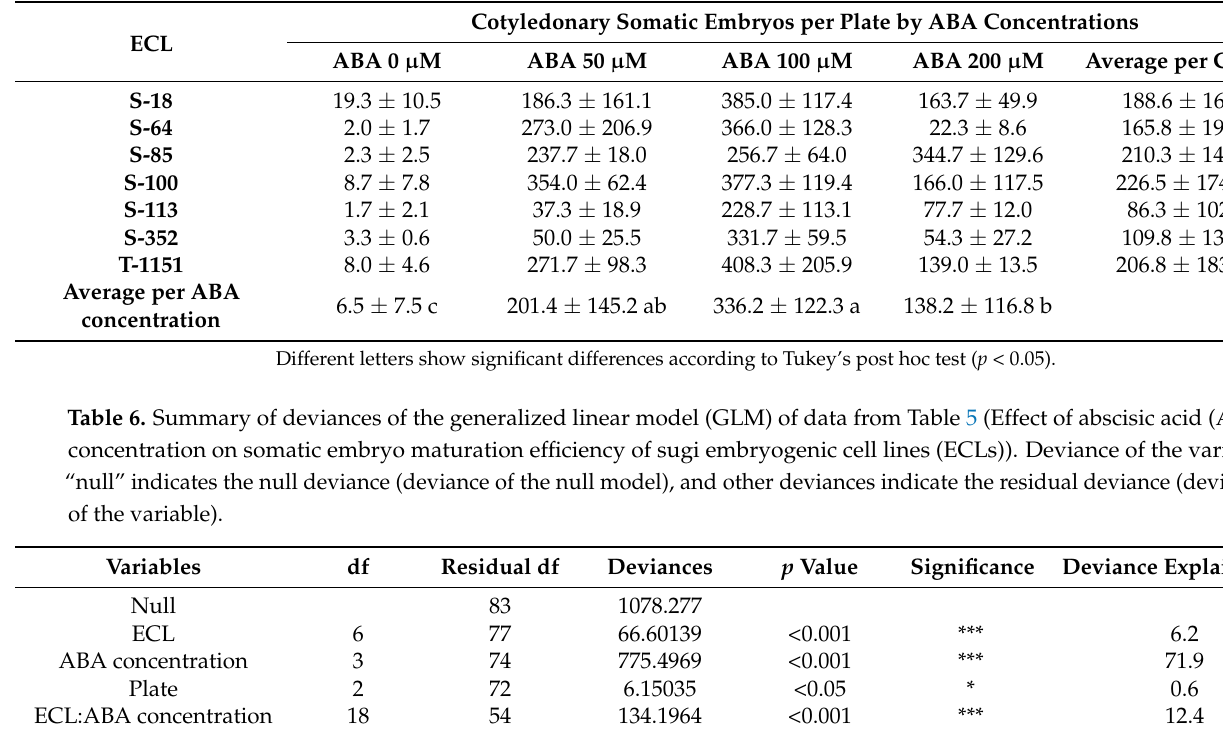
Table 5. Effect of abscisic acid (ABA) concentration on somatic embryo maturation efficiency of sugi embryogenic cell lines (ECLs). Data are presented as the mean ± SD (standard deviation) of the number of cotyledonary somatic embryos per plate from three replicates for each ECL matured on media containing different concentrations of ABA.